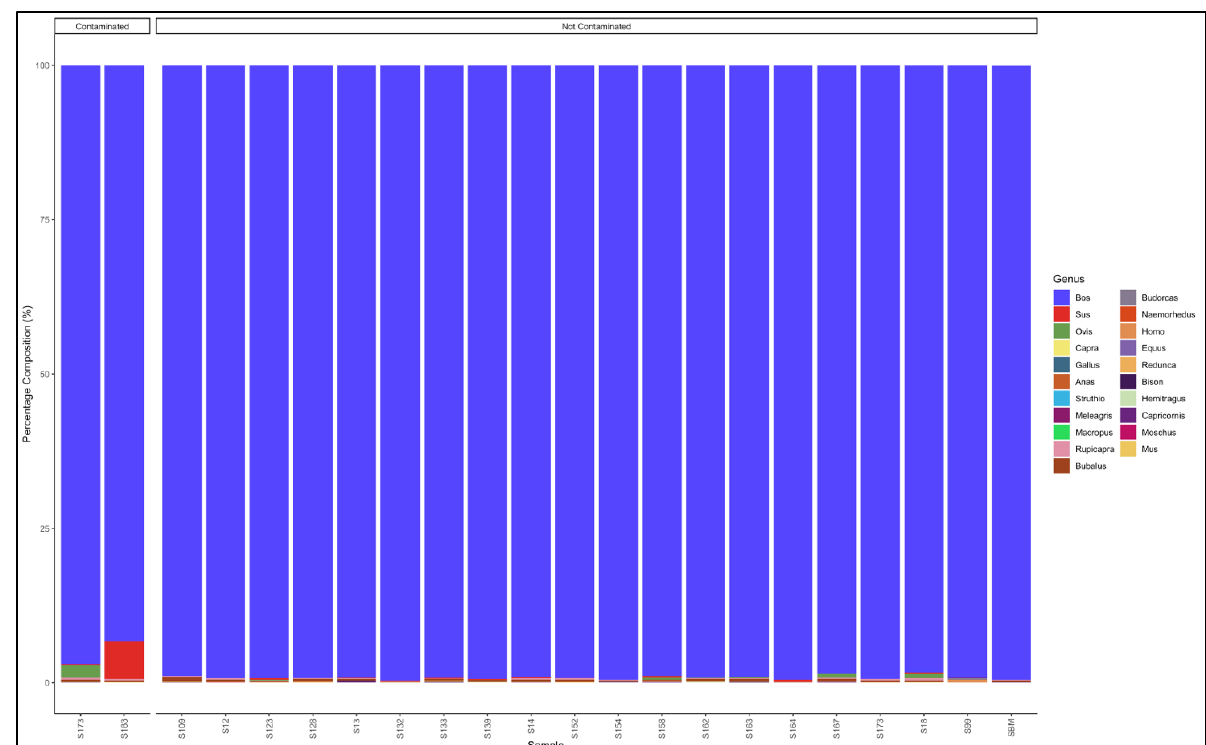
Figure 7. Percentage composition of samples labeled as beef mince.